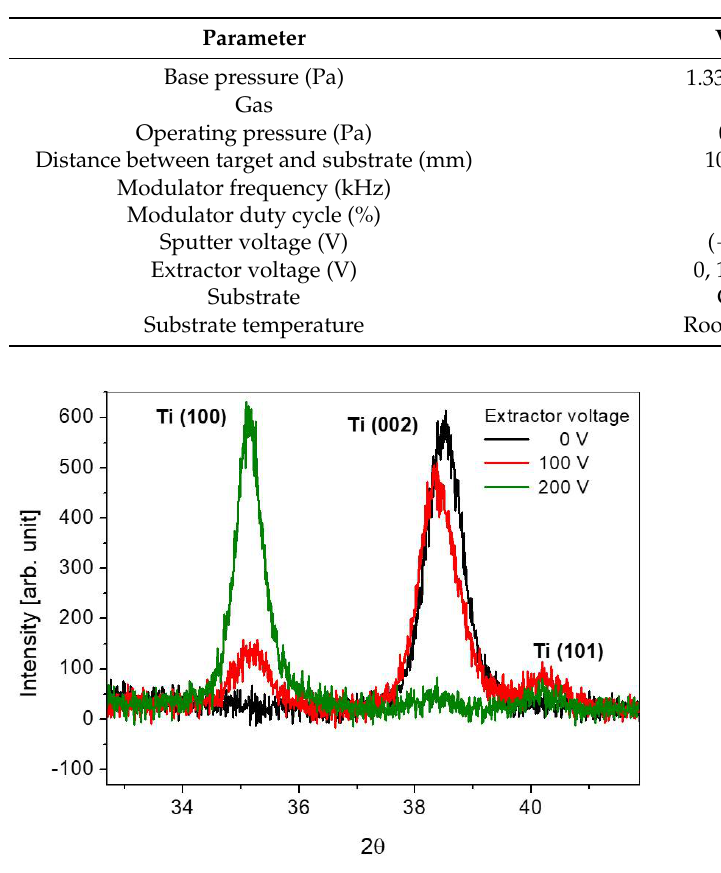
Table 2. Experimental conditions for Ti deposition using an asymmetric bipolar-pulsed power sputtering (ABPPS) system.